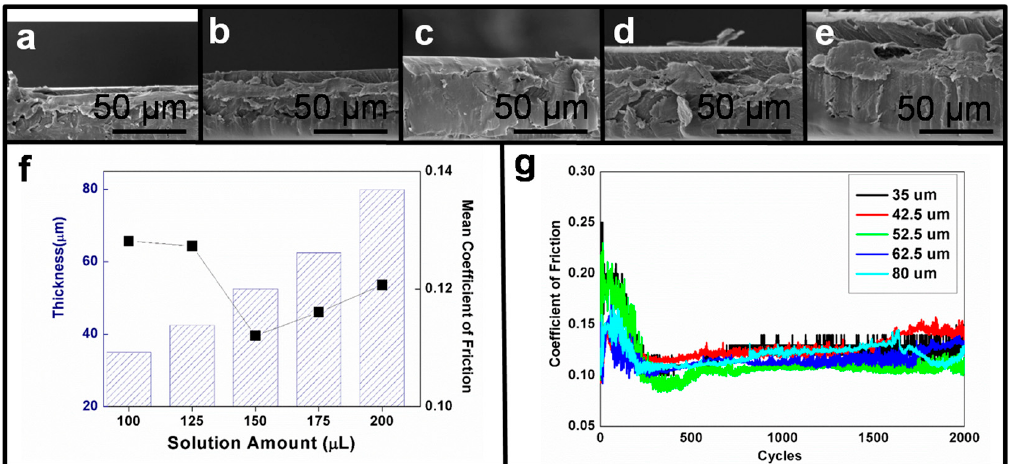
Figure 3. For the thickness distribution of the HPMC films, the amounts of HPMC used were ( a ) 100 µ L; ( b ) 125 µ L; ( c ) 150 µ L; ( d ) 175 µ L; and ( e ) 200 µ L; ( f ) Distribution of film thickness according to different amounts of HPMC and average coefficient of friction (COF); ( g ) Frictional behaviors with different film thicknesses.